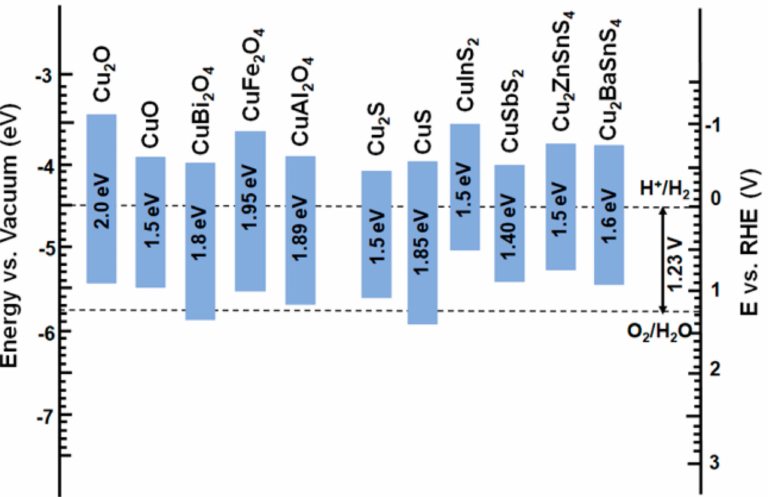
Figure 3. Energy band diagram of the various Cu-based binary, ternary, and quaternary metal oxides and